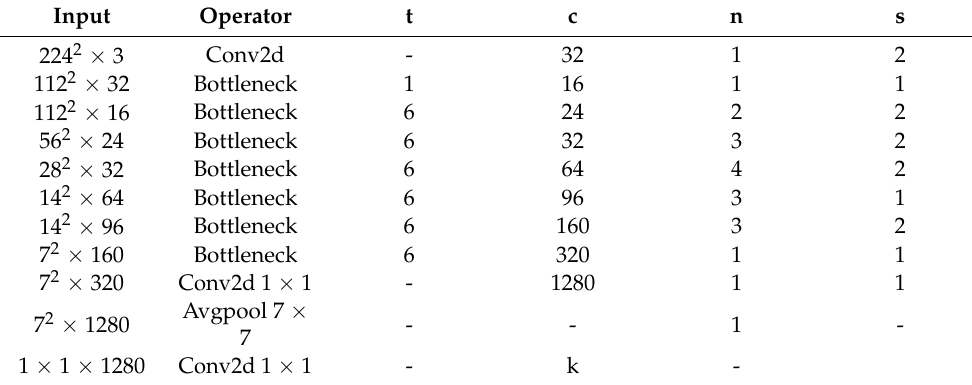
Table 1. MobileNetV2 network